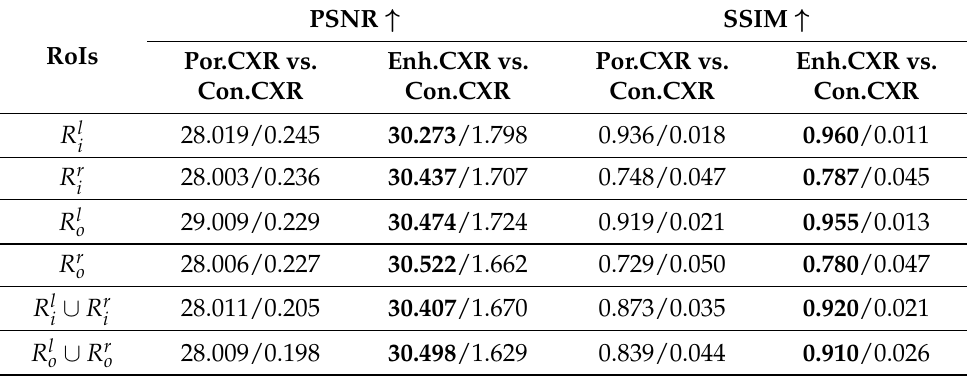
Table 2. Mean/std of PSNR and SSIM for the inner left lung R l R l o , and outer right lung R r o between the portable CXR (Por.CXR) and conventional CXR (Con.CXR) and between enhanced the CXR (Enh.CXR) and conventional CXR (Con.CXR).